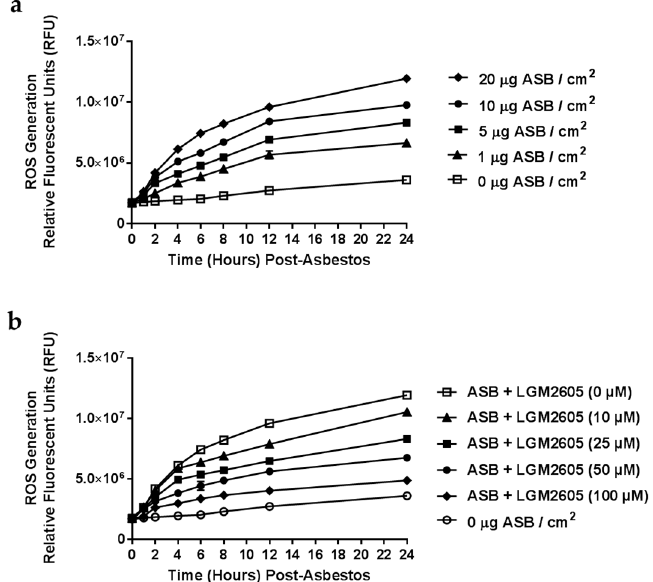
Figure 1. Determination of Dose-Response Following Asbestos Exposure and LGM2605. ( a ) Elicited murine peritoneal macrophages were plated in a 96-well plate (2 × 10 4 cells/well) and exposed to various concentrations of sterile, standard UICC (Union Internationale Contre le Cancer) crocidolite (SPI Supplies, West Chester, PA, USA) asbestos fibers (0, 1, 5, 10, and 20 µg/cm 2 ) to first assess the dose-dependent increase in asbestos-induced ROS generation; ( b ) Various concentrations (0, 10, 25, 50, and 100 µM) of synthetic SDG (LGM2605) were administered 4-h prior to exposure to crocidolite asbestos (20 µg/cm 2 ). Culture medium was evaluated for ROS generation using the cell-permeant fluorescent probe 2 ′ ,7 ′ -dichlorodihydrofluorescein diacetate (H2DCFDA).